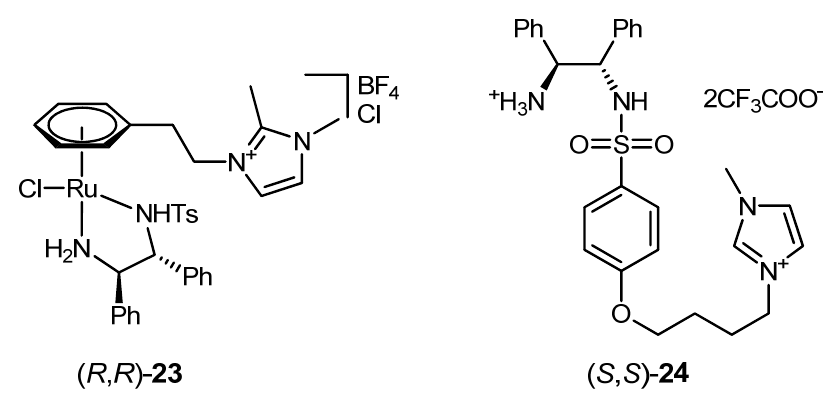
Figure 6. Ligands designed for ATH in ionic liquids.